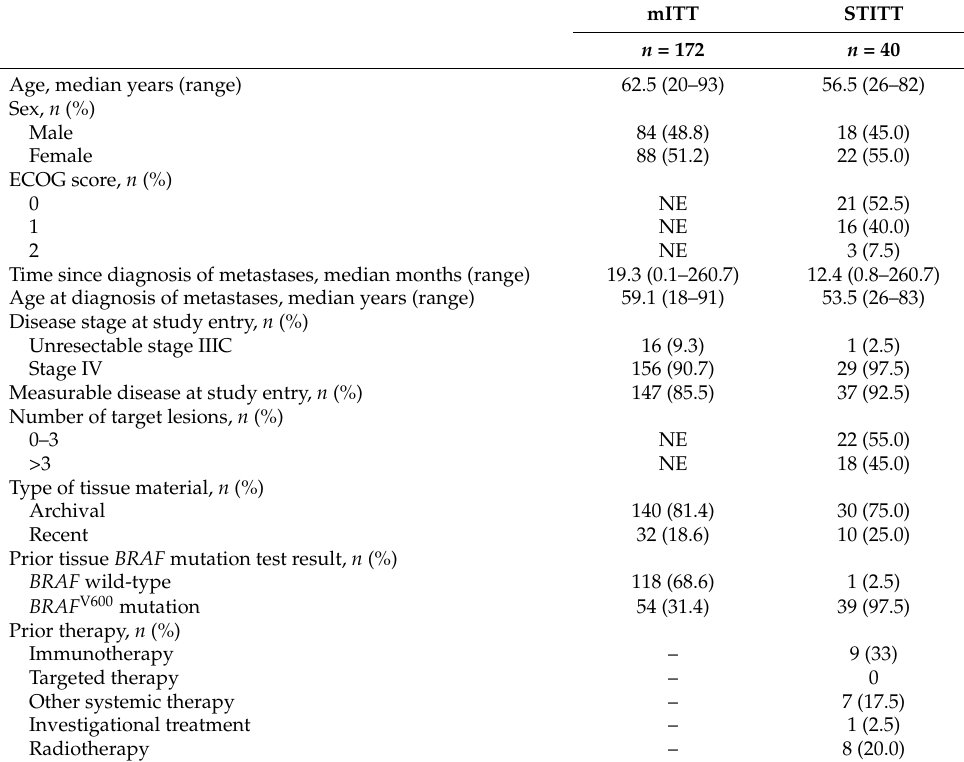
Table 1. Baseline demographic, disease, biopsy, and mutation